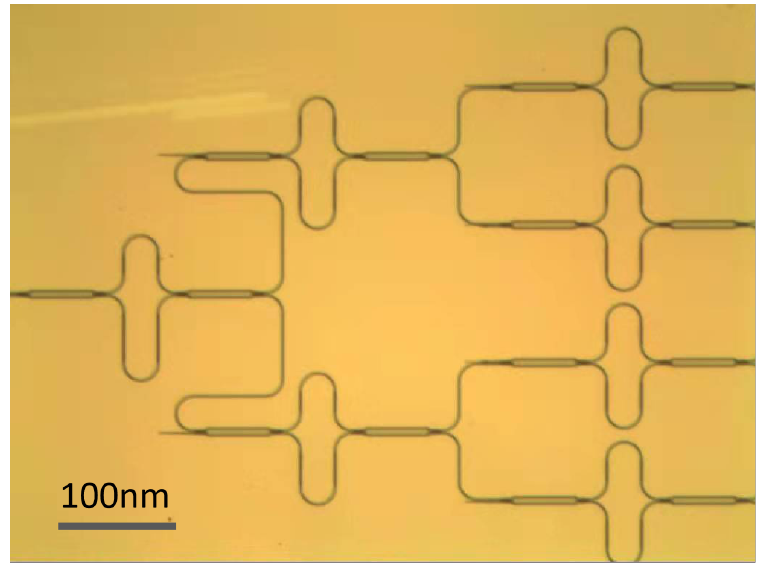
Figure 4. The microscope images of the fabricated 8-channel LAN WDM (de)multiplexer.